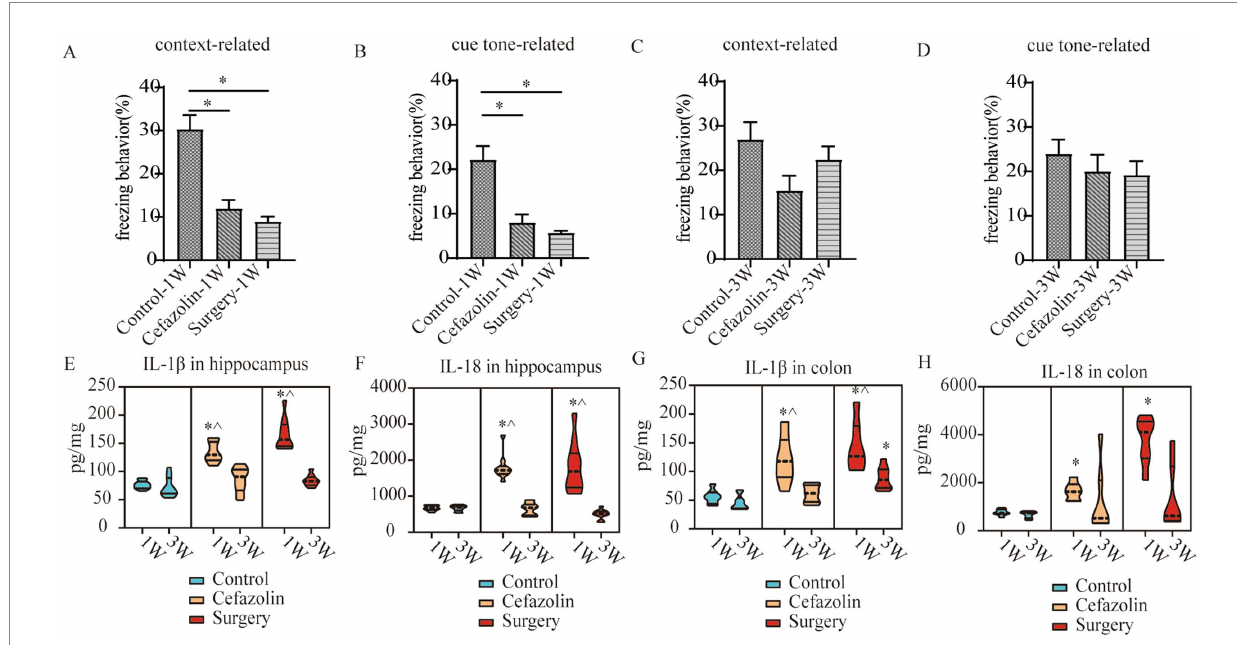
FIGURE 5 Cefazolin-induced and surgery/anesthesia stress-induced inflammation and cognitive dysfunction, respectively. (A) Context-related freezing behavior at 1 week of Grp CTL, Grp CEF, Grp S; (B) Cue tone-related freezing behavior at 1 week of Grp CTL, Grp CEF, Grp S; (C) Context-related freezing behavior at 3 weeks of Grp CTL, Grp CEF, Grp S; (D) Cue tone-related freezing behavior at 3 weeks of Grp CTL, Grp CEF, Grp S; (E) ELISA for the level of IL-1 β in the hippocampus at 1 and 3 weeks of Grp CTL, Grp CEF, Grp S; (F) ELISA for the level of IL-18 in the hippocampus at 1 and 3 weeks of Grp CTL, Grp CEF, Grp S; (G) ELISA for the level of IL-1 β in the colon at 1 and 3 weeks of Grp CTL, Grp CEF, Grp S; (H) ELISA for the level of IL-18 in the colon at 1 and 3 weeks of Grp CTL, Grp CEF, Grp S. Grp, group; CTL, control; CEF, cefazolin; S, surgery. *Compared with 3 weeks, p <